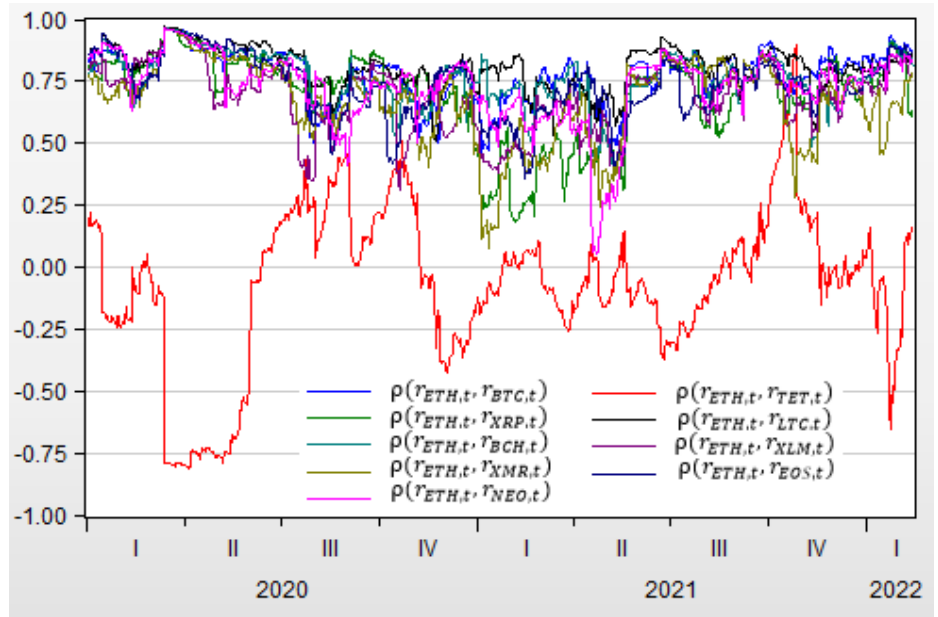
Figure 8. Curves of the DCC between Ethereum and the other eight cryptocurrencies for the COVID- 19